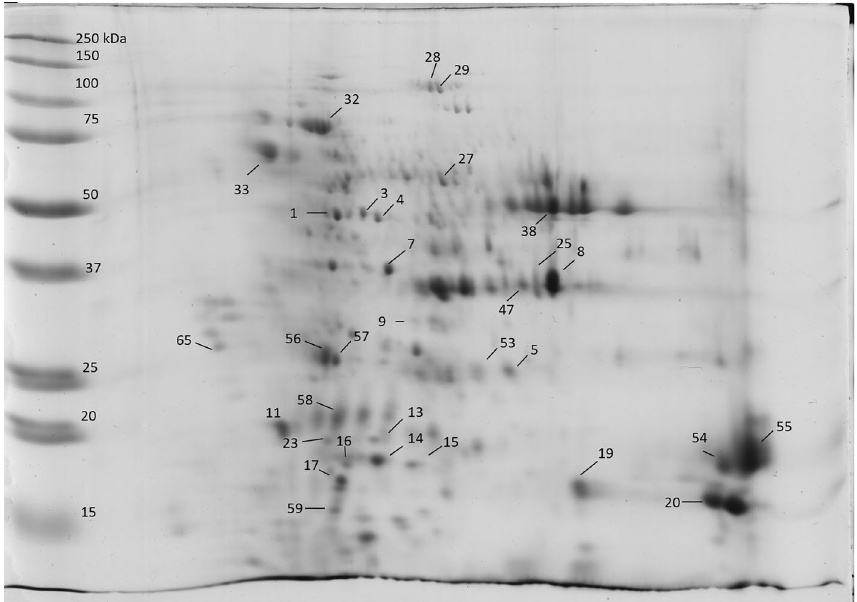
Figure 3. Representative 2D gel of the albumin fraction: the spots identified by MS analysis are numbered.